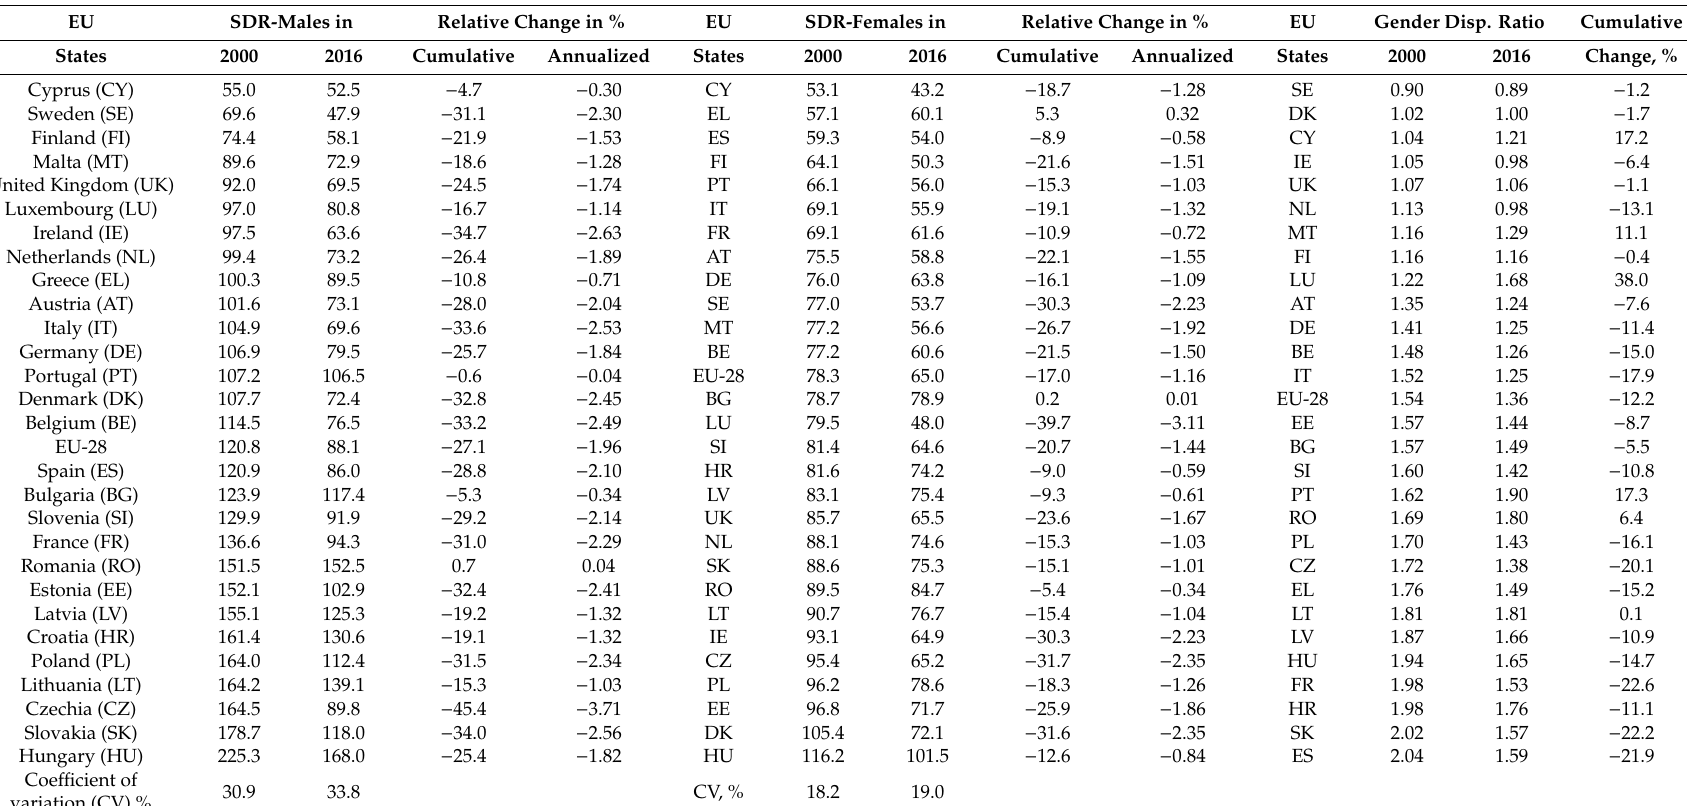
Table 2. Premature SDR for malignant neoplasms in the EU countries in 2000 and 2016 1